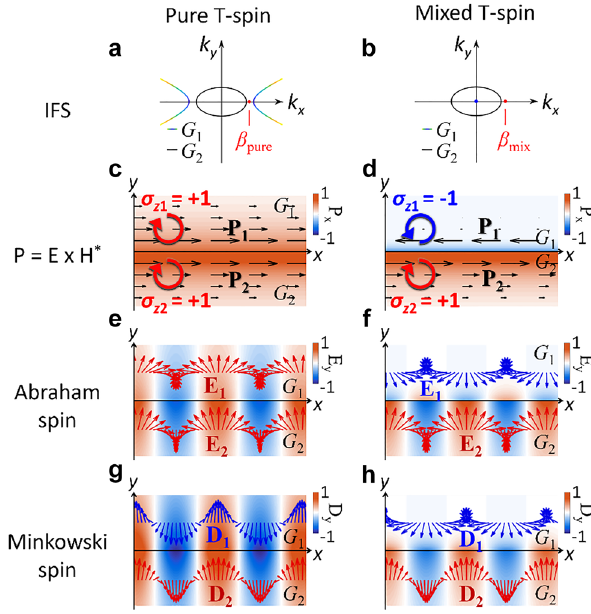
-gap materials lead x z